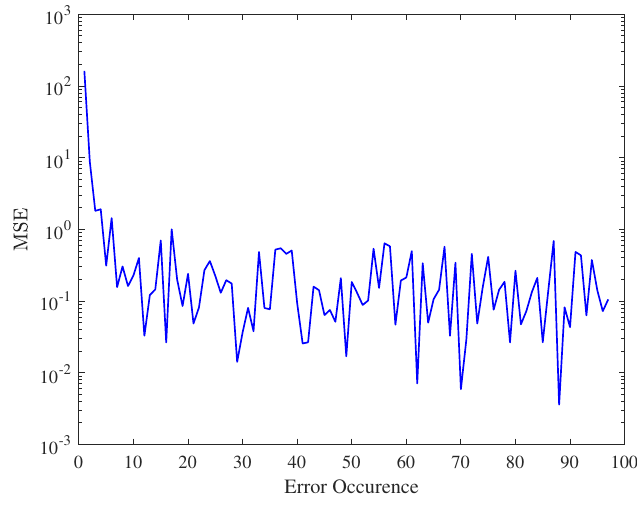
Figure 3. Minimum Mean Square Error.